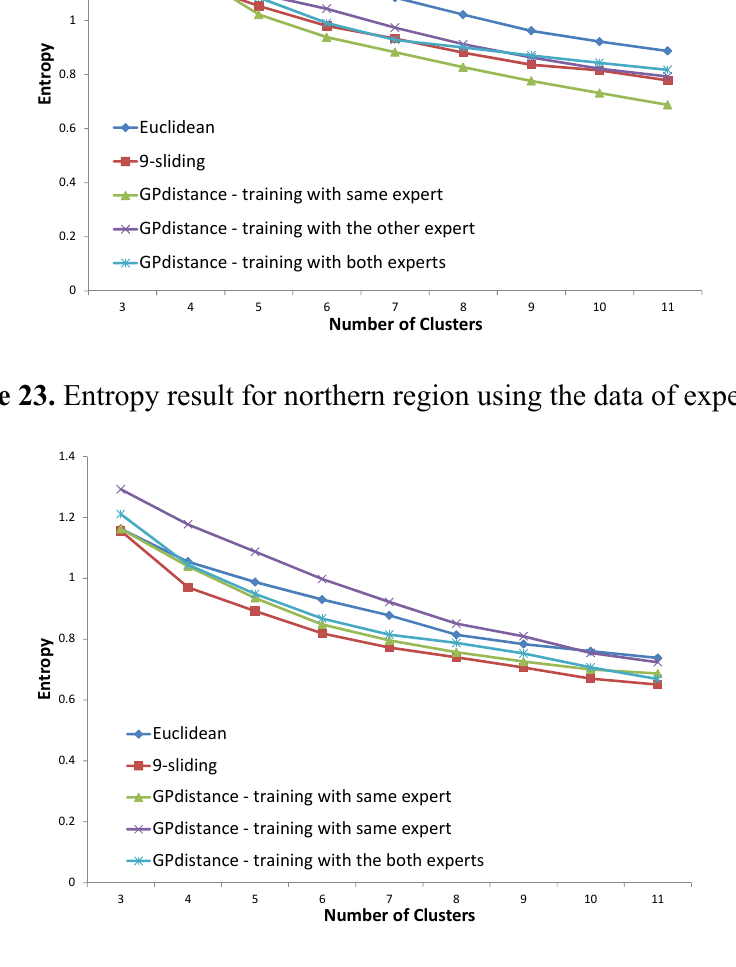
Figure 24. Entropy results for the northern region using the data of expert